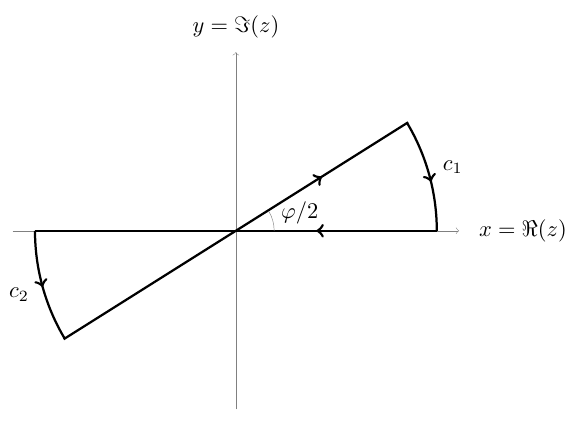
Figure 1 . The closed contour used in eq.